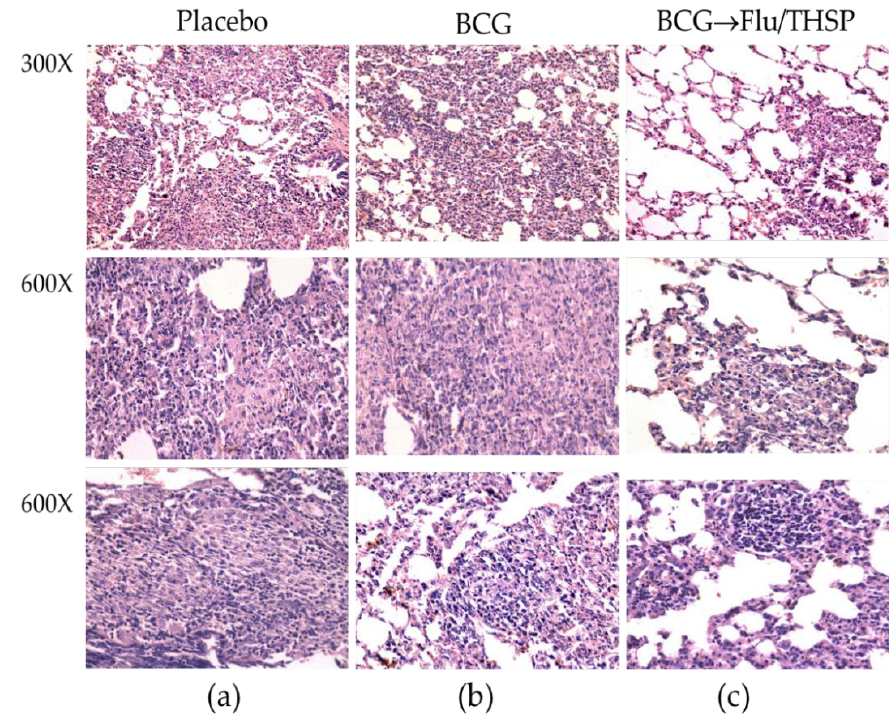
Figure 8. Protective efficacy of BCG-prime → Flu/THSP boosts immunization against lung pathology in a guinea pig model of TB infection. Representative H&E stained lung histological sections of vaccinated and control guinea pigs (indicated above) after infection with M.tb H37Rv strain, magnification is indicated at the left. ( a )—intensive inflammation foci with a large number of degrading neutrophils and nuclear debris are demonstrated; merging granulomas are characterized by large areas of caseous necrosis; ( b )—the particular focus of specific infiltration can be found; ( c )—the small peribronchiolar focus of specific infiltration can be found.